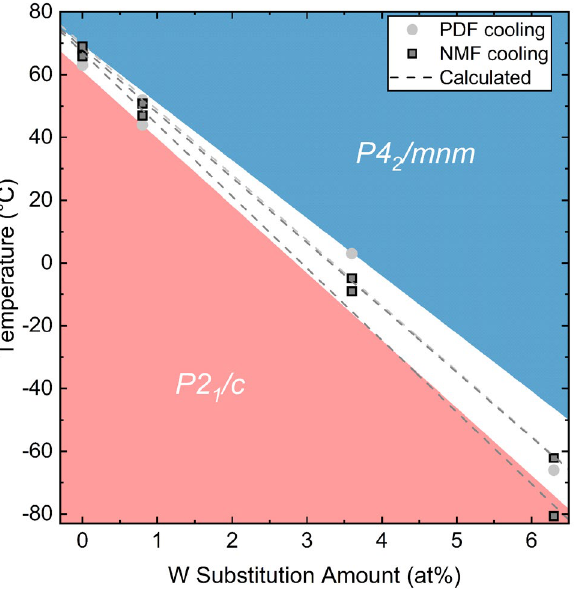
Figure 5. In-situ total scattering distribution refinements elucidated the local phase diagram for the W-substituted VO 2 system. These observations were supported through NMF analysis of both the heating and cooling data sets. Linear regressions of each data set, agree with each other and show a slower local progression of the SPT compared to the